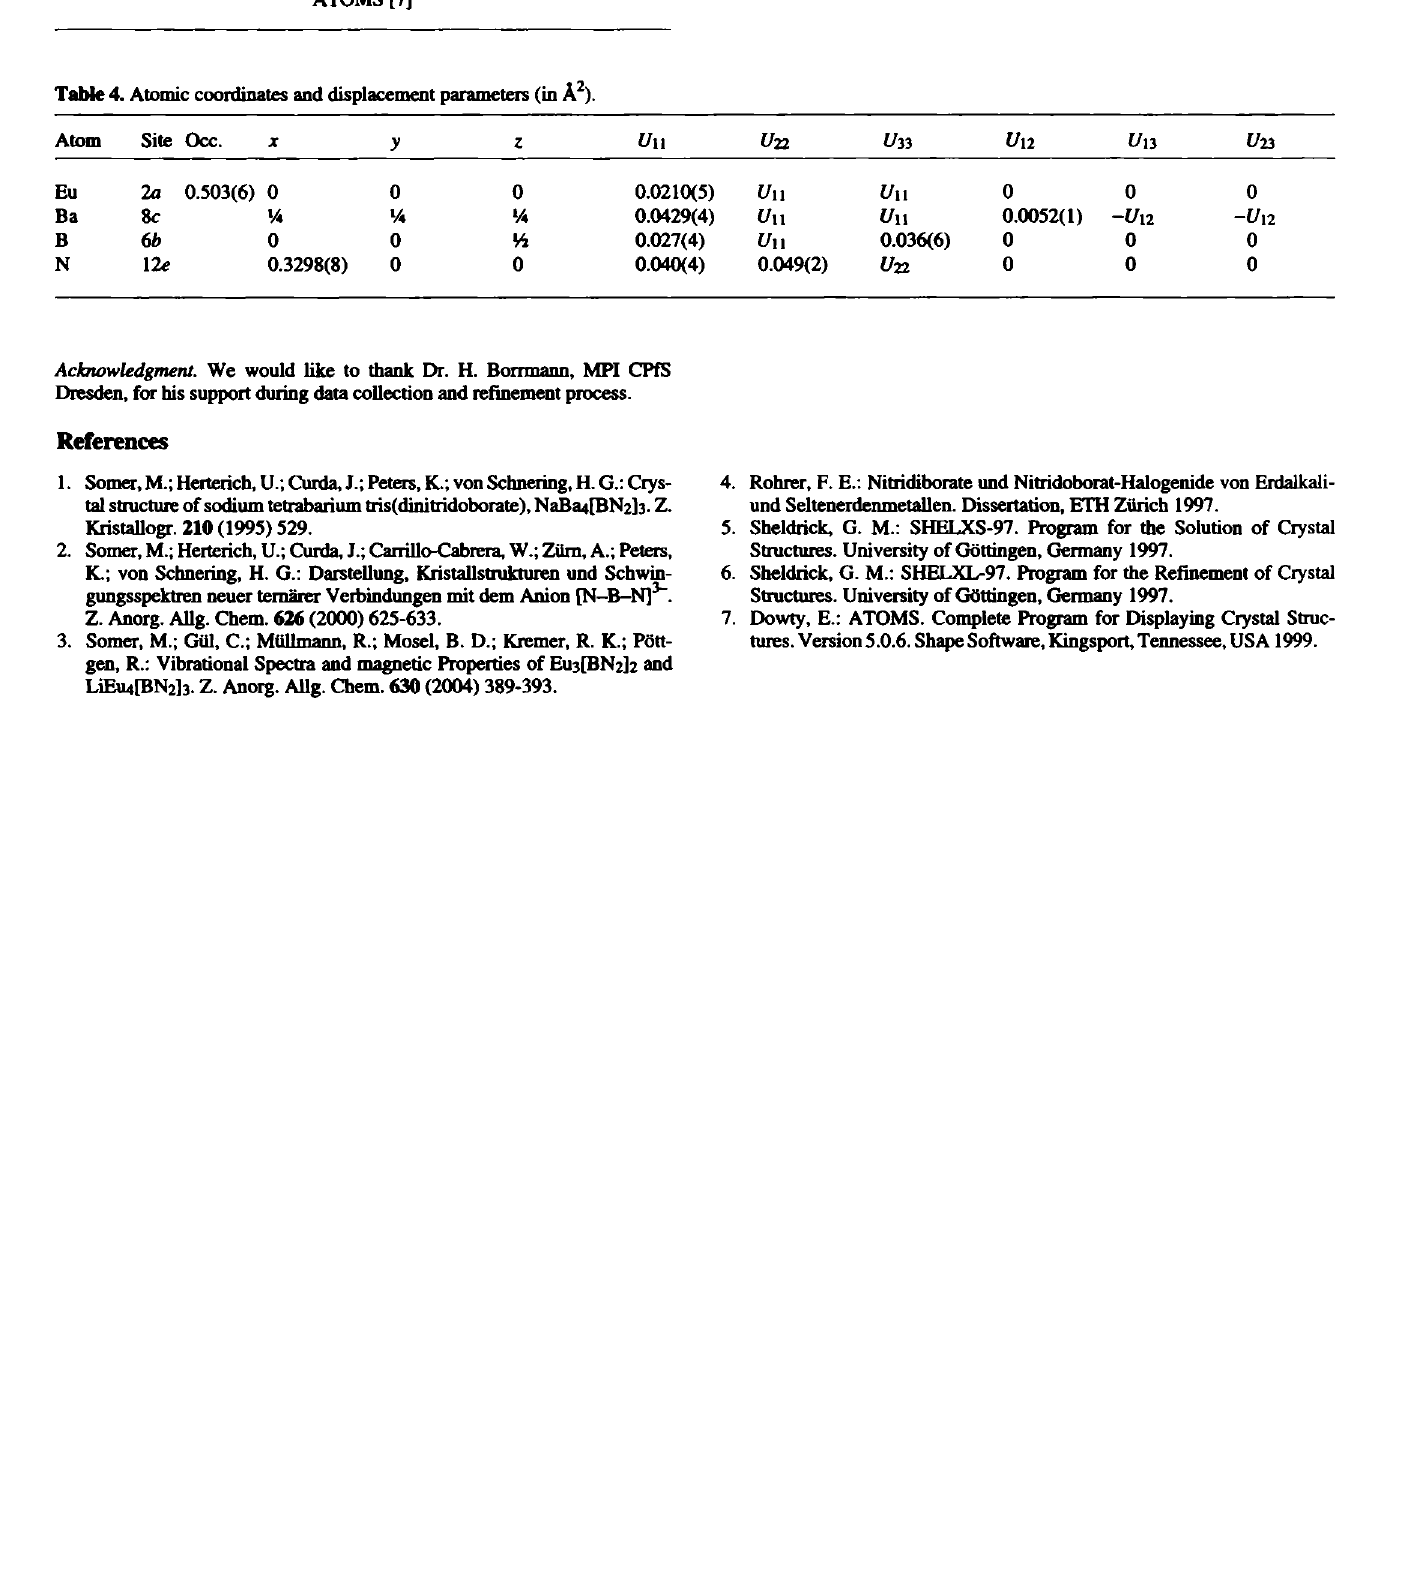
Table 3. Data collection and handling. Crystal: black plate, size 0.07 χ 0.15 χ 0.20 mm Wavelength: 771.10 cm" 1 Diffractometer, scan mode: Criterion for /ate. N(hkl) p : /obs > 2 a(Idbt), 74 Niparamjafocf. 11 Programs.